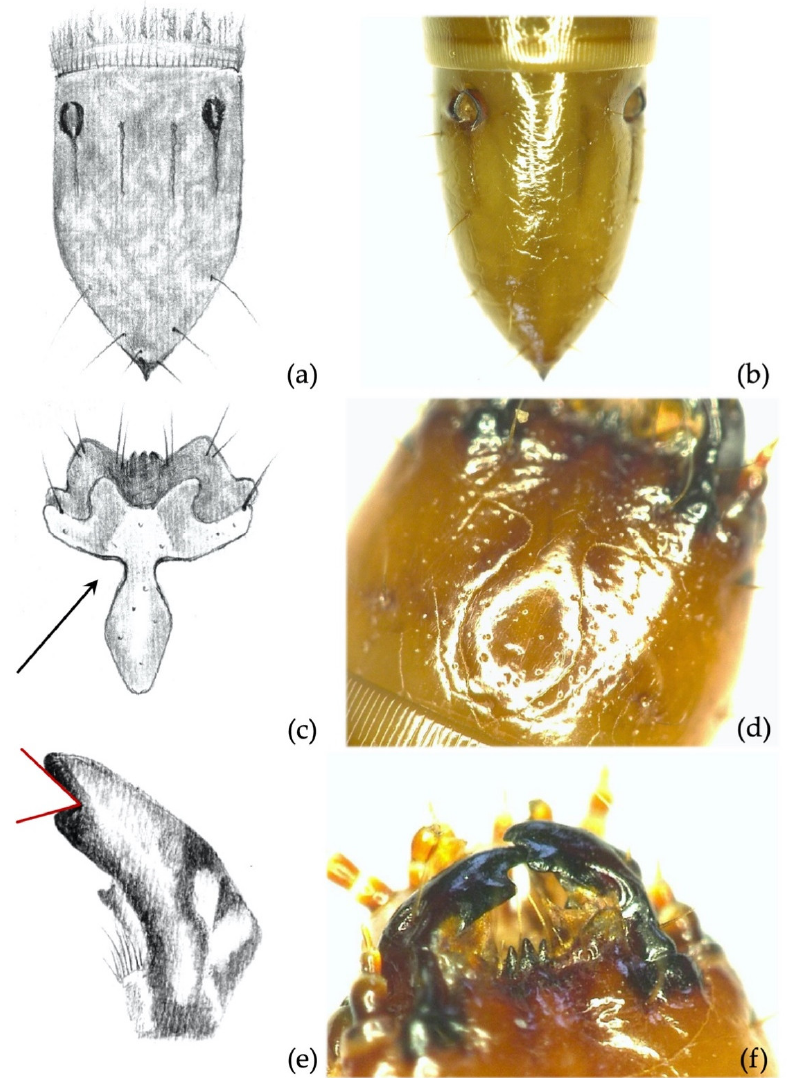
Figure 12. Agriotes lineatus (L. 1767). Discriminating characters: ( a , b ) 9th abdominal segment dorsal view showing inner and outer longitudinal lines; ( c , d ) details of the frontoclypeus forming an angle of about 90°; ( e ) details of the right mandible with subapical tooth, measured angle ≤90°; ( f ) mandibles in dorsal view. 3.1.8. Agriotes proximus (Schwarz 1891) and Agriotes rufipalpis (Brullé 1832)